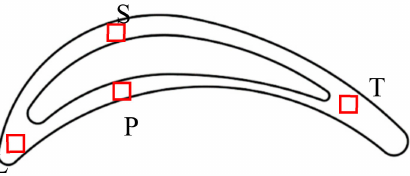
Figure 2. The collection area of the transverse section of the single crystal blade. The positions L, T, S, and P represent the area selected from leading edge, trailing edge, suction side, and pressure side, respectively.